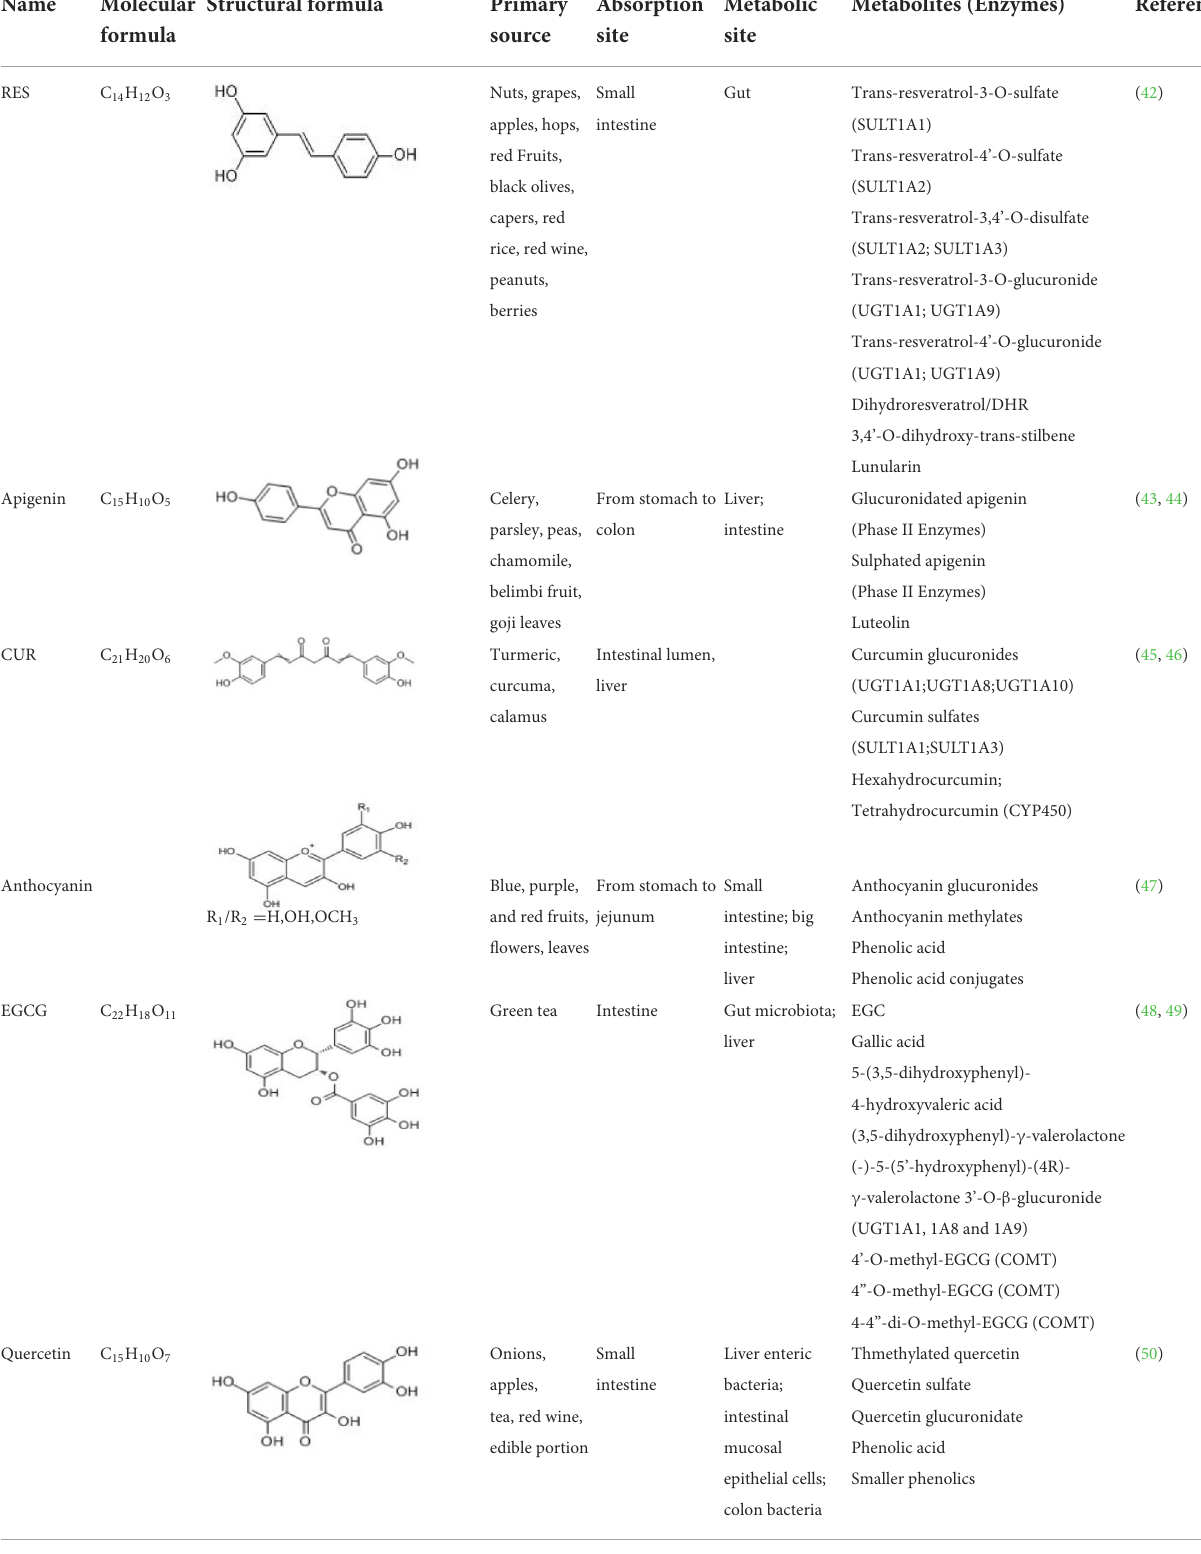
TABLE 2 Dietary polyphenols involved in this review and their names, chemical formulas, structural formulas and metabolic